Question: Write a descriptive caption for this figure.
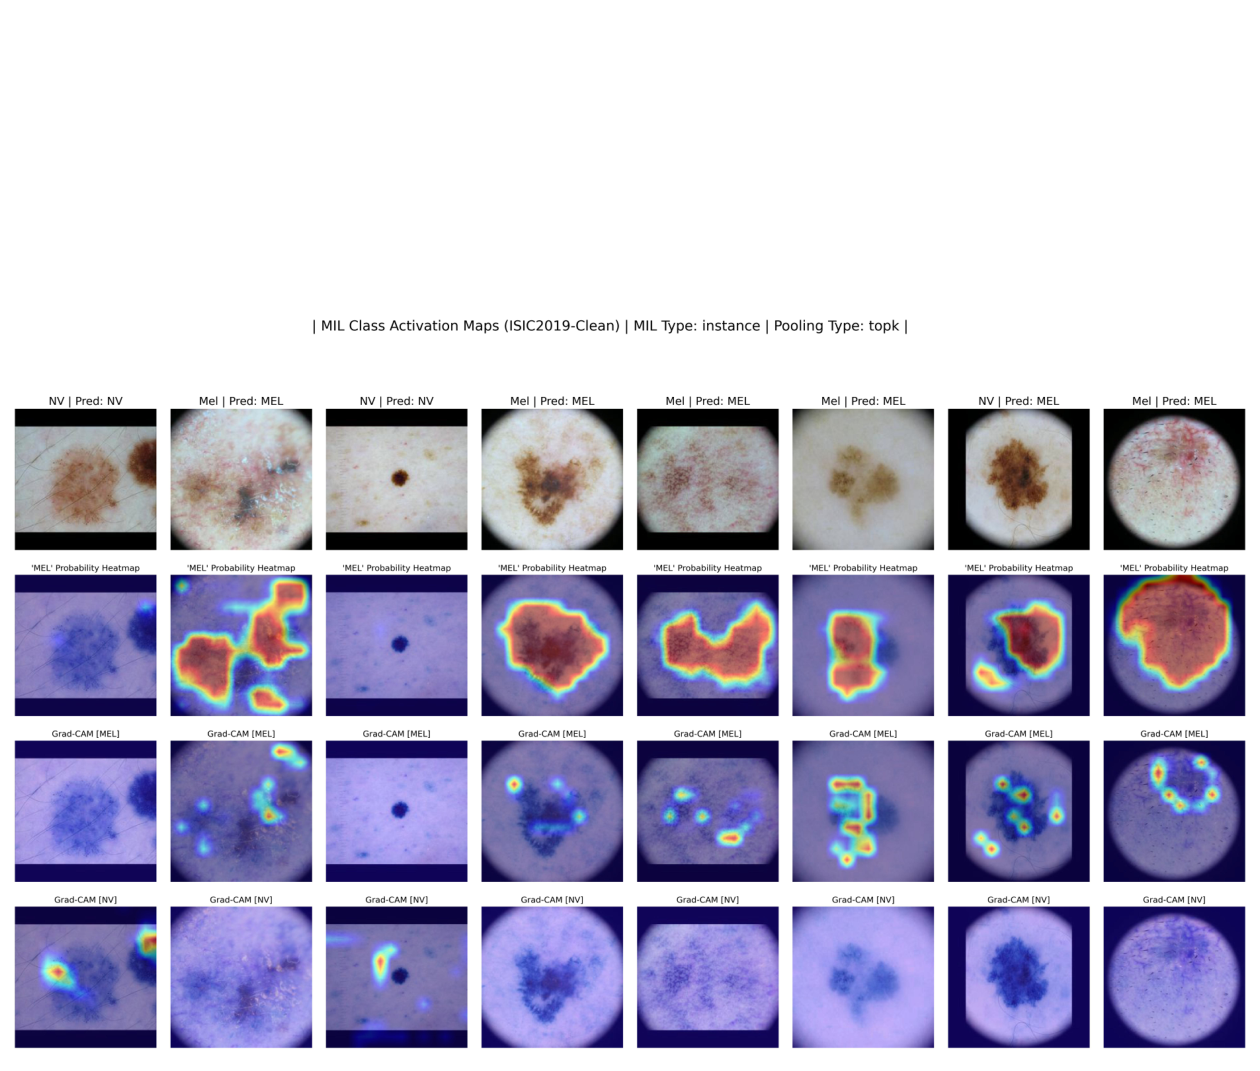
Answer: Visualization of the heatmaps generated by the MIL classifier, specifically the instance-level MIL model using the top-k average pooling operator. The backbone used for the MIL model is the RN-18. The images are taken from the validation set of the ISIC 2019 dataset, and belong to the binary problem of melanoma vs. nevus. The Figure shows the input images in the first row, followed by the patch probability heatmap for the melanoma class in the second row. The third row shows the gradient heatmap for each patch. In this case, the last row shows the gradients with respect to the patches that the model predicted to be nevus.